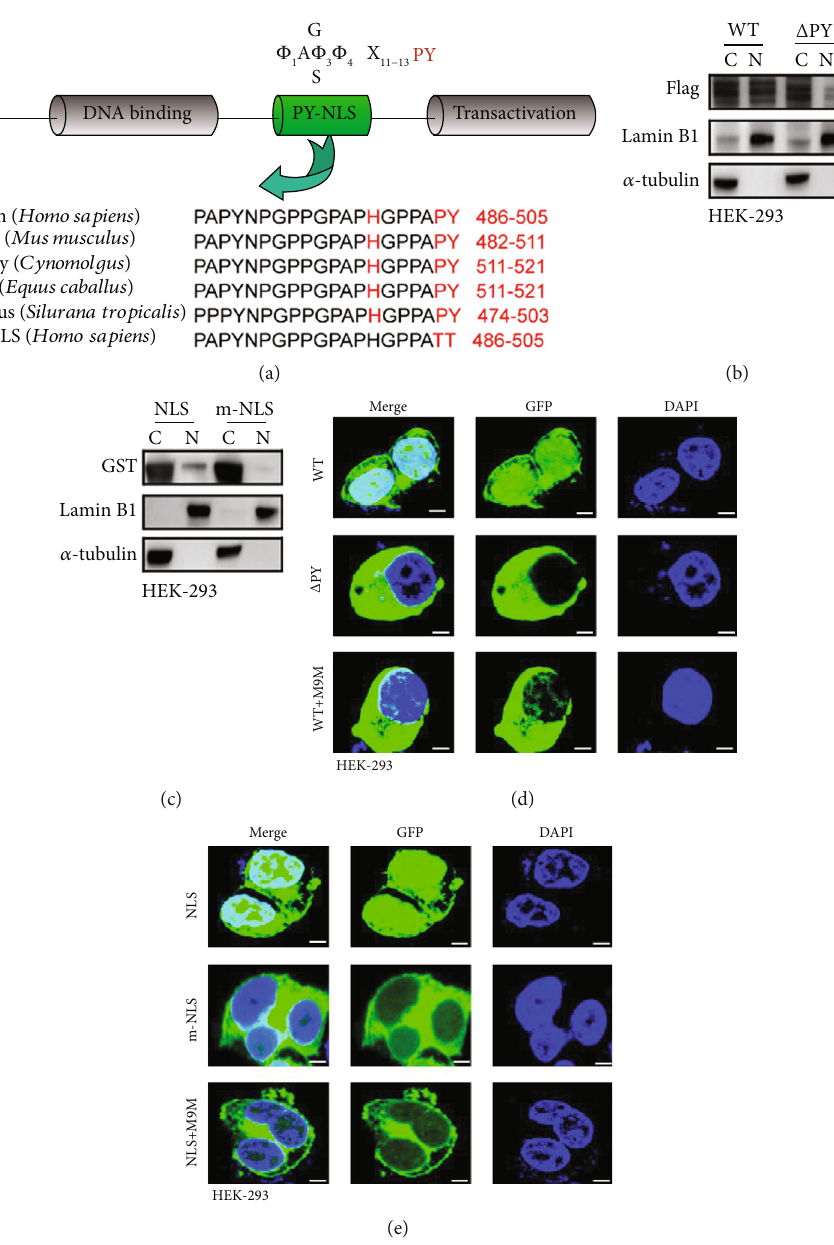
Figure 4: The PY-NLS motif is responsible for the nuclear import of FUBP1. (a) The cylinder shows the domain of the PY-NLS motif and function of FUBP1. Alignment revealing the FUBP1 PY-NLS motif from various mammalian species. (b) Immunoblots shows the FUBP1 and mutant levels in the nucleoplasm and cytoplasm of HEK-293 cell. (c) Immunoblots shows the PY-NLS and mutant levels in the nucleoplasm and cytoplasm. (d) Confocal microscopy of FUBP1 and mutant levels. (e) Confocal microscopy of PY-NLS and mutant levels. Scar bar 20 μ